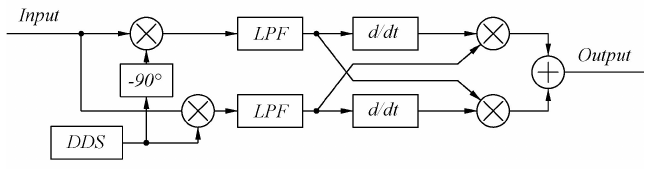
Figure 5. Diagram of the real − time frequency calculation